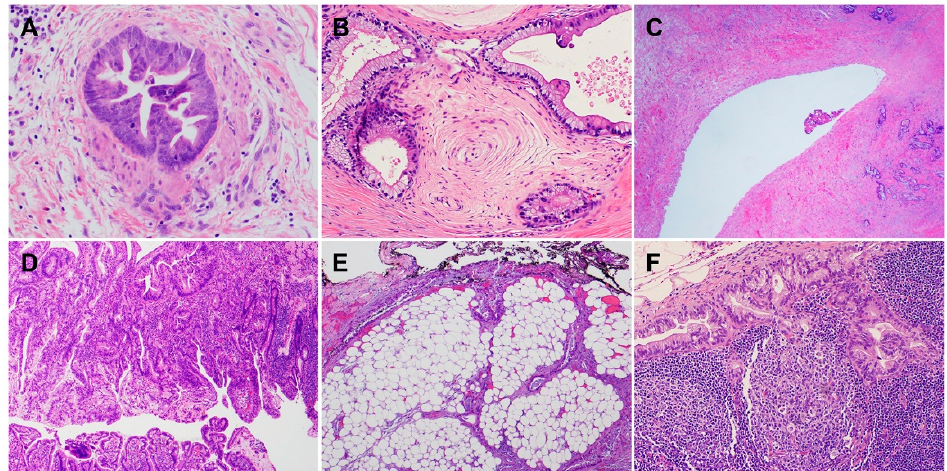
Figure 2. The common histological features associated with aggressive clinical outcomes for pan- creatic cancer patients (hematoxylin and eosin stain). ( A ) Tumor invasion into muscular vessels; ( B ) perineural invasion; ( C ) tumor invasion into the wall of superior mesenteric vein; ( D ) PDAC inva- sion through the muscularis propria of the duodenum and involves the mucosal surface; ( E ) PDAC invades into the peripancreatic and retroperitoneal soft tissue and involves the uncinate margin (marked by black ink); ( F ) metastatic PDAC in a regional lymph node.